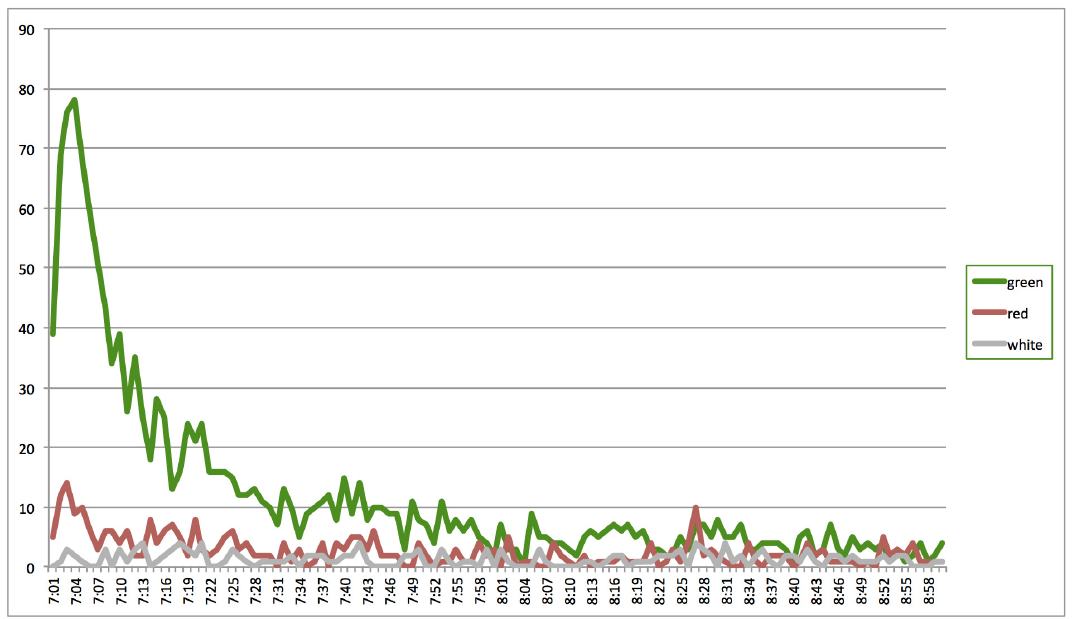
Figure 4. Tweets written after the May 29, 2012, seismic shake (7:00 a.m.-8:59 a.m. UTC) according to users’ locations (green, red and white zones of Figure